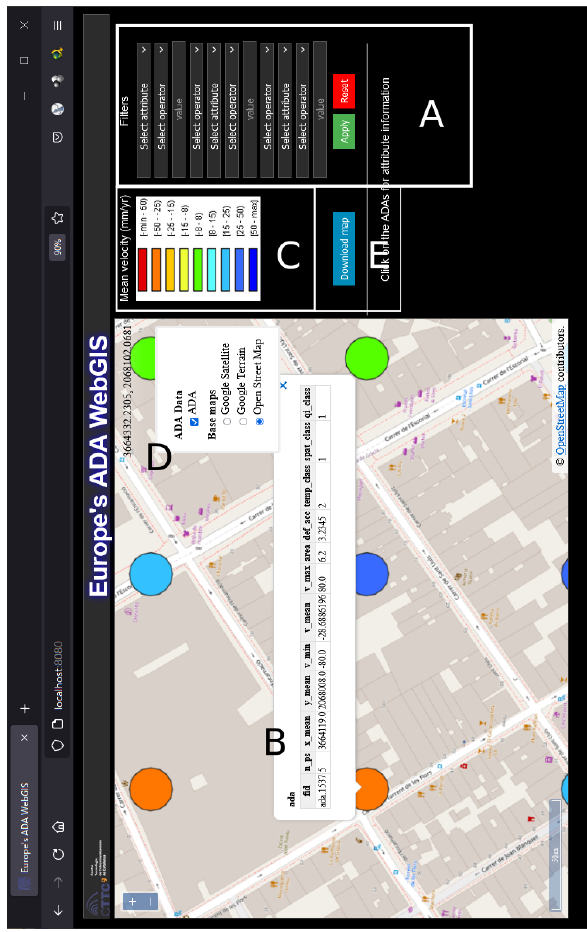
Figure 6. The WebGIS (rotated